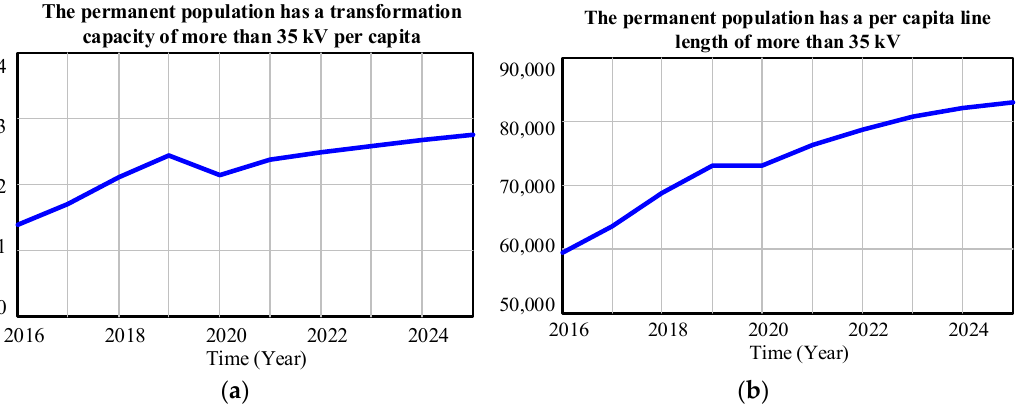
Figure 9. ( a ) The permanent population has a transformation capacity of more than 35 kV per capita from 2016 to 2025; ( b ) the Predicted value of the proportion of the permanent population has a per capita line length of more than 35 kV from 2016 to 2025.